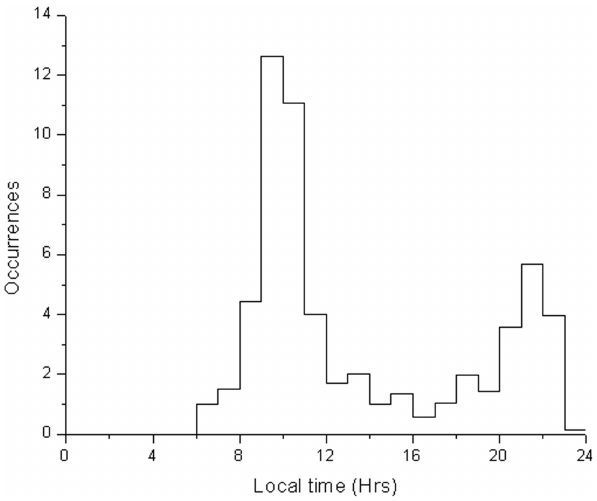
Fig. 2. The occurrence rate of ELF whistlers with respect to local